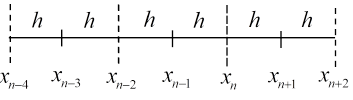
Figure 1. Two point block